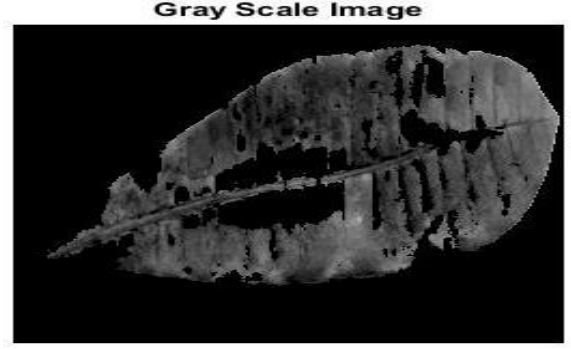
Figure 11. Gray scale image using cluster 1 and 90°co- occurrence angle